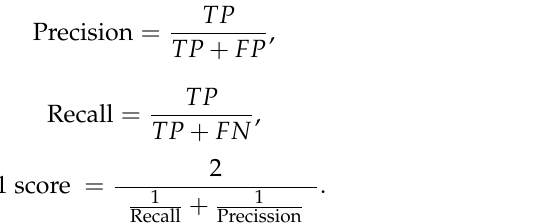
19 of 24 Table 3. Confusion matrix for fixed hyperparameter classification. P REDICTED 1